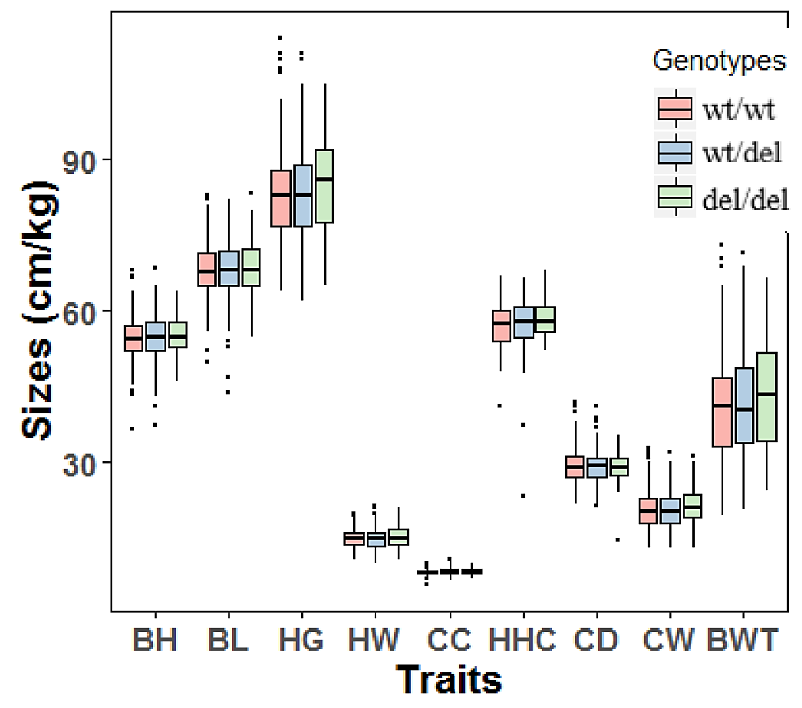
Figure 5. The associations of the 12 bp variation of PRDM6 and body measurement traits of adult